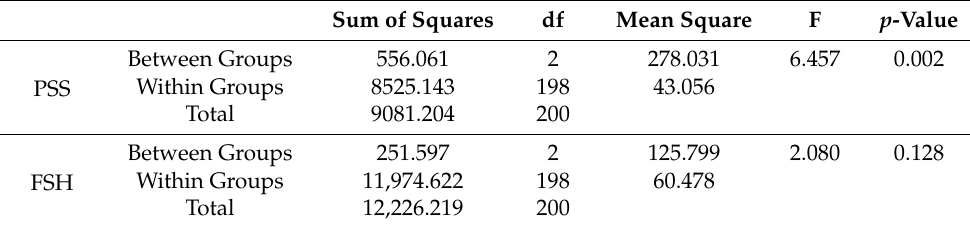
Table 7. ANOVA test output for personal safety and sexual harassment with regards to work experience.